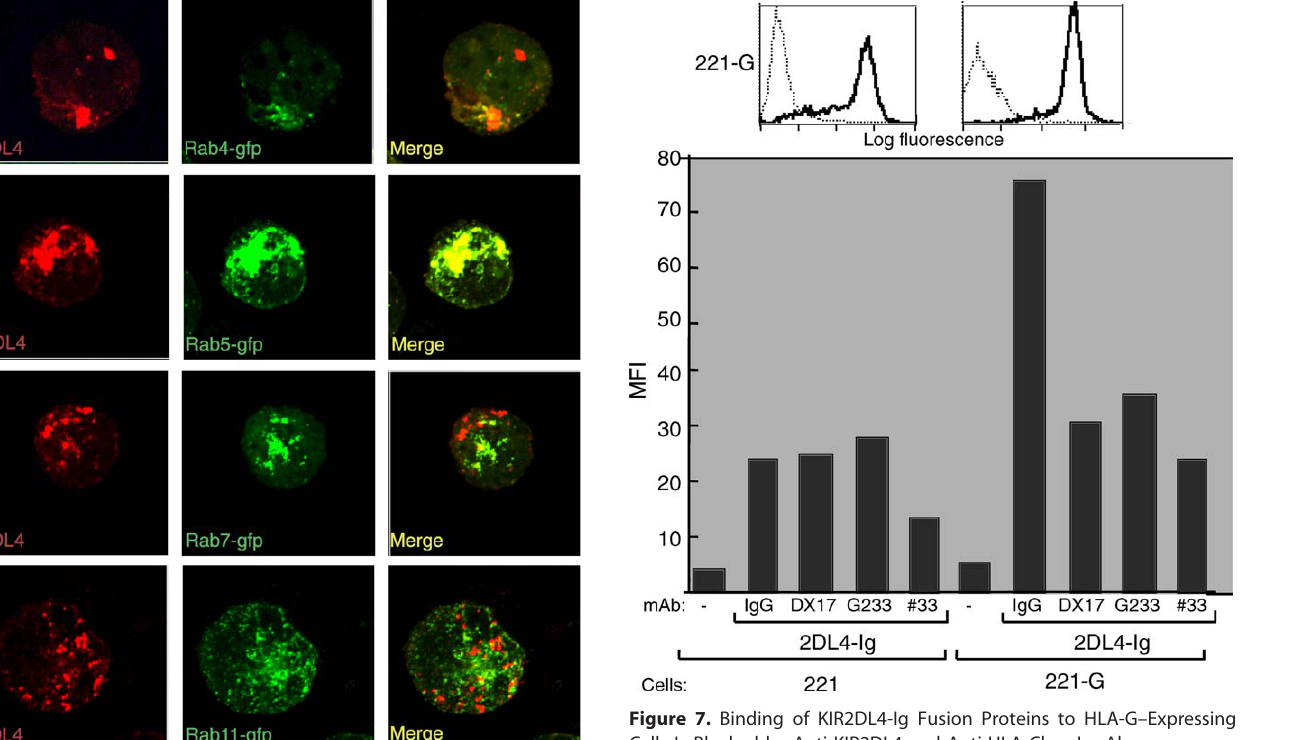
Figure 8. Cell Surface Shed and Secreted, Soluble HLA-G Is Endocytosed into KIR2DL4-Containing Vesicles (A) Endocytosis of soluble HLA-G in resting NK cells. The 221 cells and 221 cells transfected with HLA-Cw3 (221-Cw3) were fixed, permeabilized, and stained with mAb F4/326. Resting NK cells were incubated at 37 8 C for 120 min with soluble, refolded HLA-C or HLA-G. Cells were then fixed, permeabilized, and stained with reagents to detect HLA-C (F4/326) or HLA-G (G233) as indicated. (B) The NK cell line YTS-2DL4-gfp was loaded at 37 8 C for 120 min with refolded HLA-G. Cells were fixed, permeabilized, and stained with mAb G233 to detect co-localization of soluble HLA-G with gfp-tagged KIR2DL4. (C) Recombinant soluble molecules of HLA-G but not HLA-C are endocytosed into 293T-2DL4-gfp cells. Refolded HLA-G and HLA-C were incubated with 293T-2DL4-gfp cells for 2 h. Cells were then fixed, permeabilized, and stained with either mAb G233 (to detect endocytosed HLA-G; upper) or mAb F4/ 326 (to detect endocytosed HLA-C; middle). (D) The 293T-2DL4-gfp cells were co-cultured with an equal number of 221 cells, 221 cells expressing transmembrane HLA-G (221-G), and 221 cells expressing a soluble isoform of HLA-G (221-sG) for 48 h. Adherent 293T-2DL4-gfp cells were fixed, permeabilized, and stained with mAb G233 followed by Alexa-568–conjugated secondary antibodies prior to acquisition of confocal images. Two 221-G cells are visible in the middle panel. DOI: 10.1371/journal.pbio.0040009.g008 PLoS Biology |